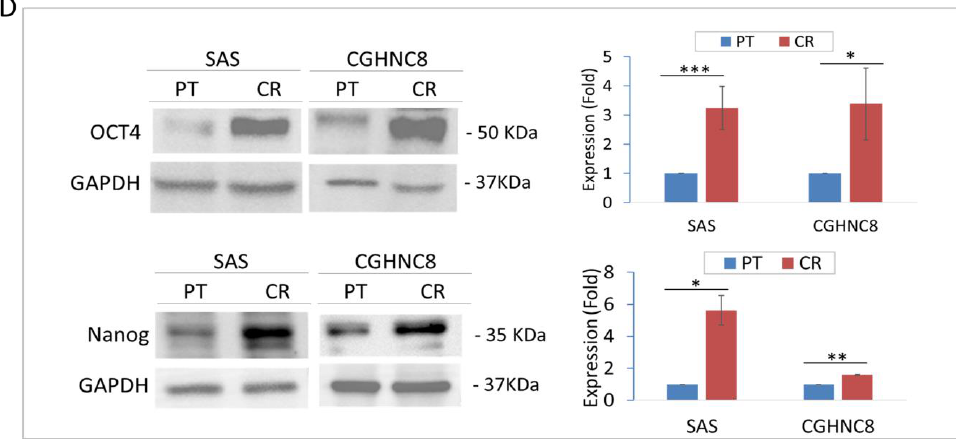
Figure 2. The CR sublines exhibit highly invasive and cancer stemness properties. ( A ) Morphological appearance of CR cells compared to the parental (PT) cells, as examined by microscopy. ( B ) Cell invasion of CR and PT cells, as determined by a Matrigel invasion assay. The numbers of cells that had invaded through the Matrigel to the bottom chamber were determined after 16 h. ( C ) Tumorsphere formation by CR and PT cells as examined by tumorsphere assay, as described in the Methods. The ability of tumorsphere formation was quantified by the determination of relative sphere numbers. ( D ) The expression of stemness regulators (Nanog and OCT4) were evaluated in SAS-CR and CGHNC8-CR cells by immunoblot analysis and quantified by the determination of relative band density. The expression level of GAPDH was used as an internal control. (*: p ≤ 0.05, **: p ≤ 0.01, ***: p ≤ 0.001).